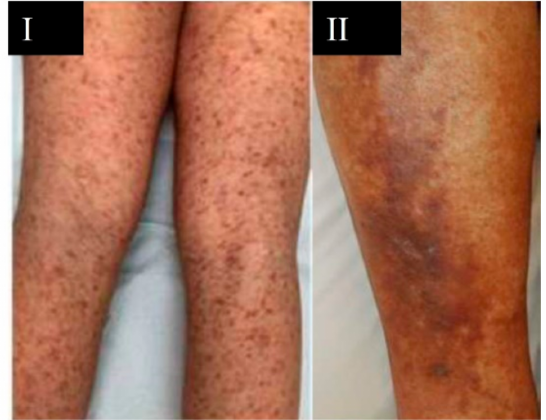
Figure 3. Purpura associated with COVID-19. ( I ) Purpuric lesions on the lower extremities; ( II ) purpuric plaques on the leg. Garc í a-Molina C. (2020)